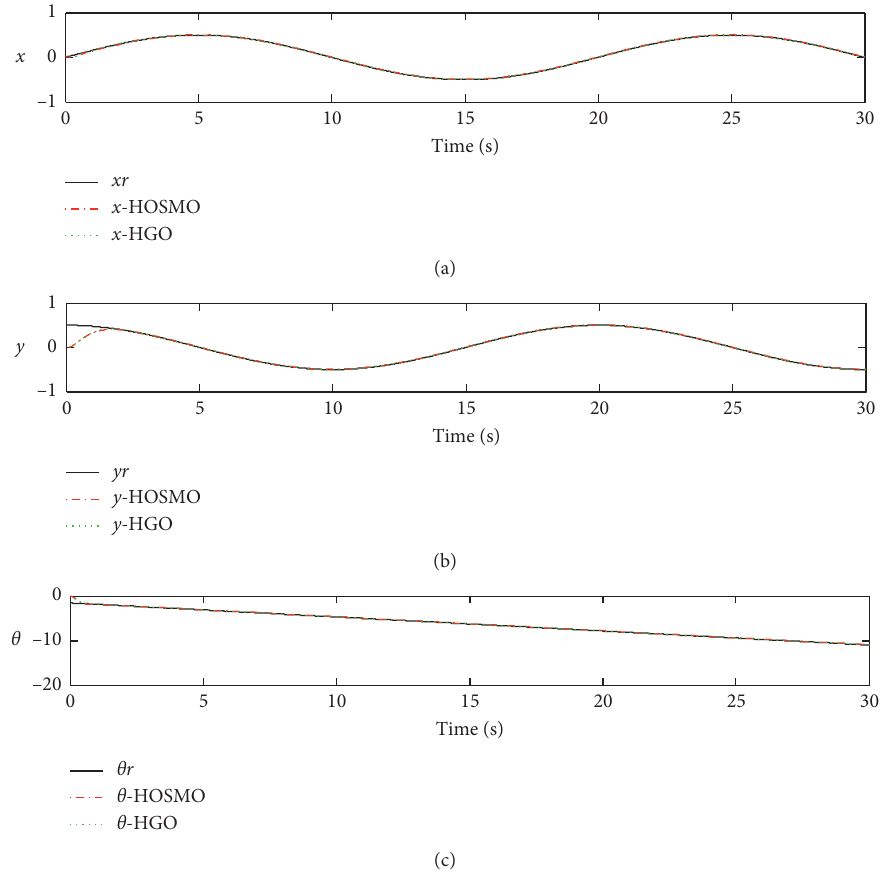
Figure 9: Comparison chart of two observers, respectively, estimating pose signals.